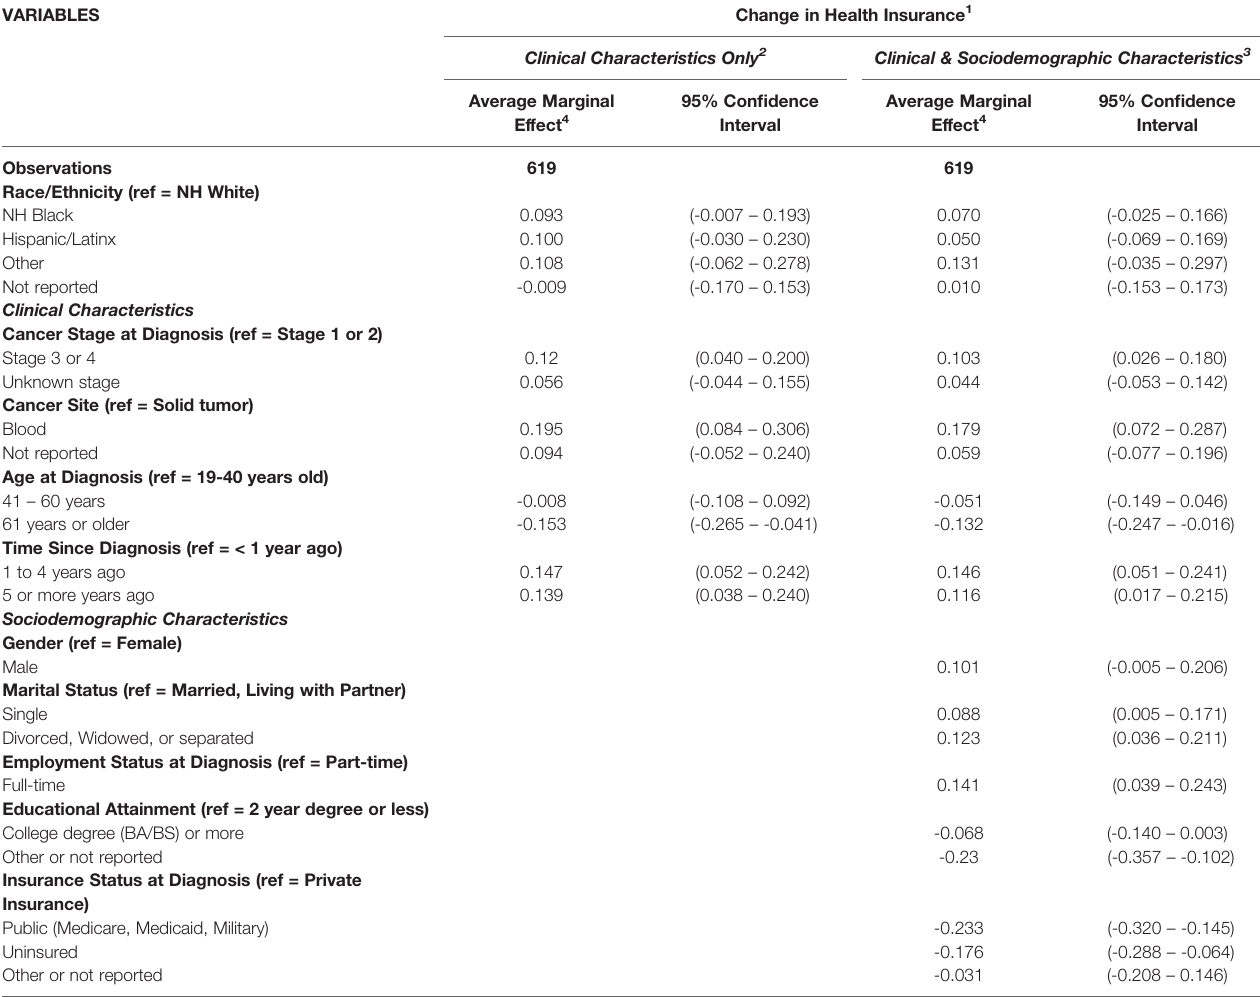
TABLE 3 | Multivariable associations between patient characteristics and employment-related changes in health insurance coverage in a sample of employed patients with cancer who received assistance from a national non-pro fi t (Oct – Nov 2019).